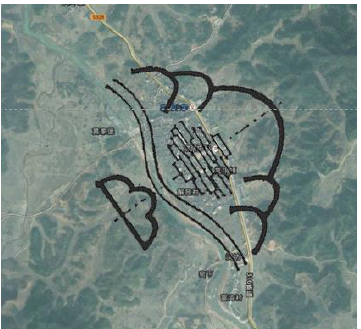
Figure9. The Column-and-tie Construction (Picture source: download from internet and self-photography )